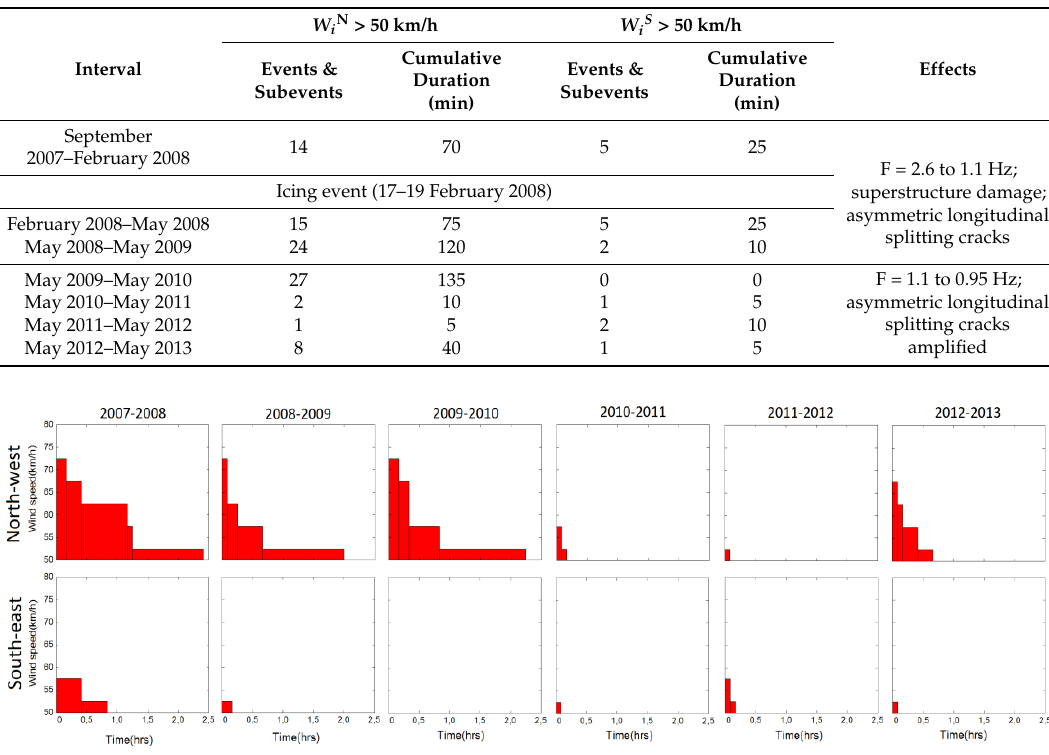
Figure 8. Selective occurrence of strong northerly wind components W iN during the six intervals defined by the seven measurement surveys. Absence of strong southerly wind components ( W iS ) justifies the scenario of Figure